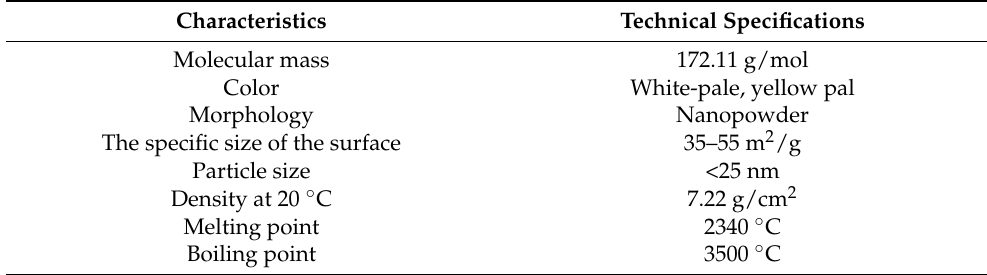
Table 1. Physical and chemical characteristics of cerium oxide.